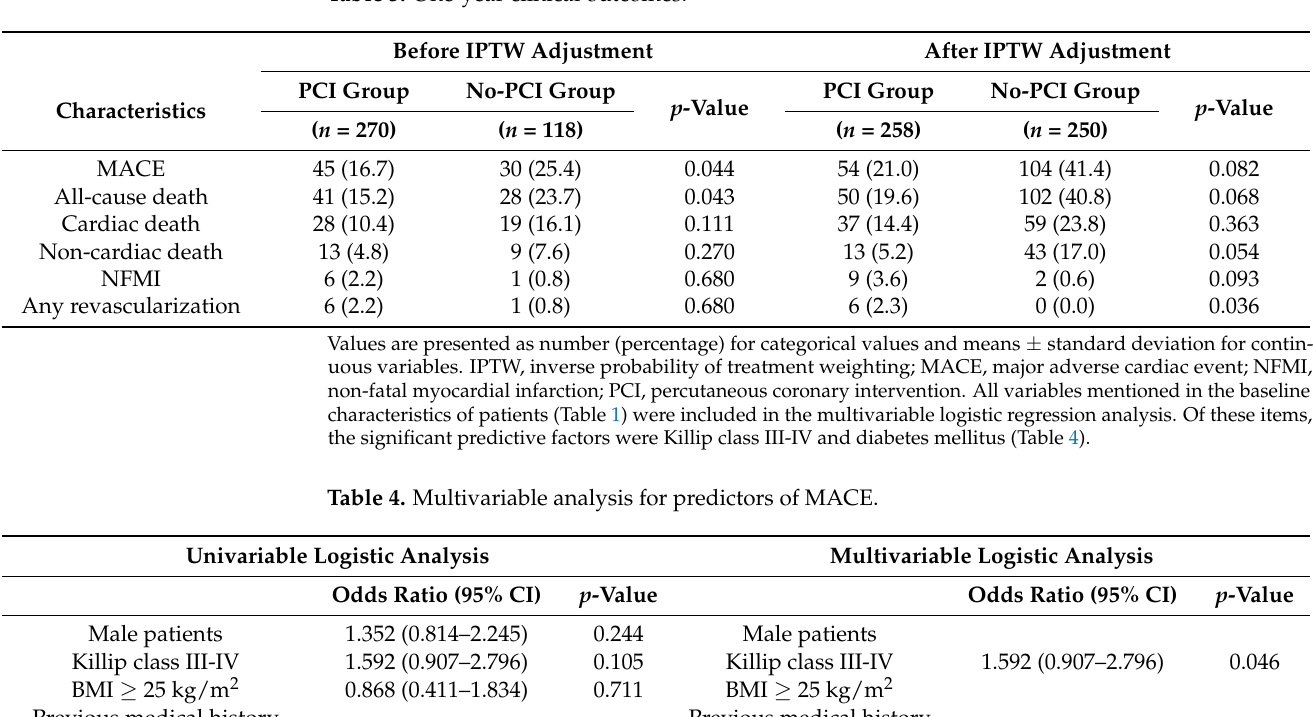
Table 3. One-year clinical outcomes.